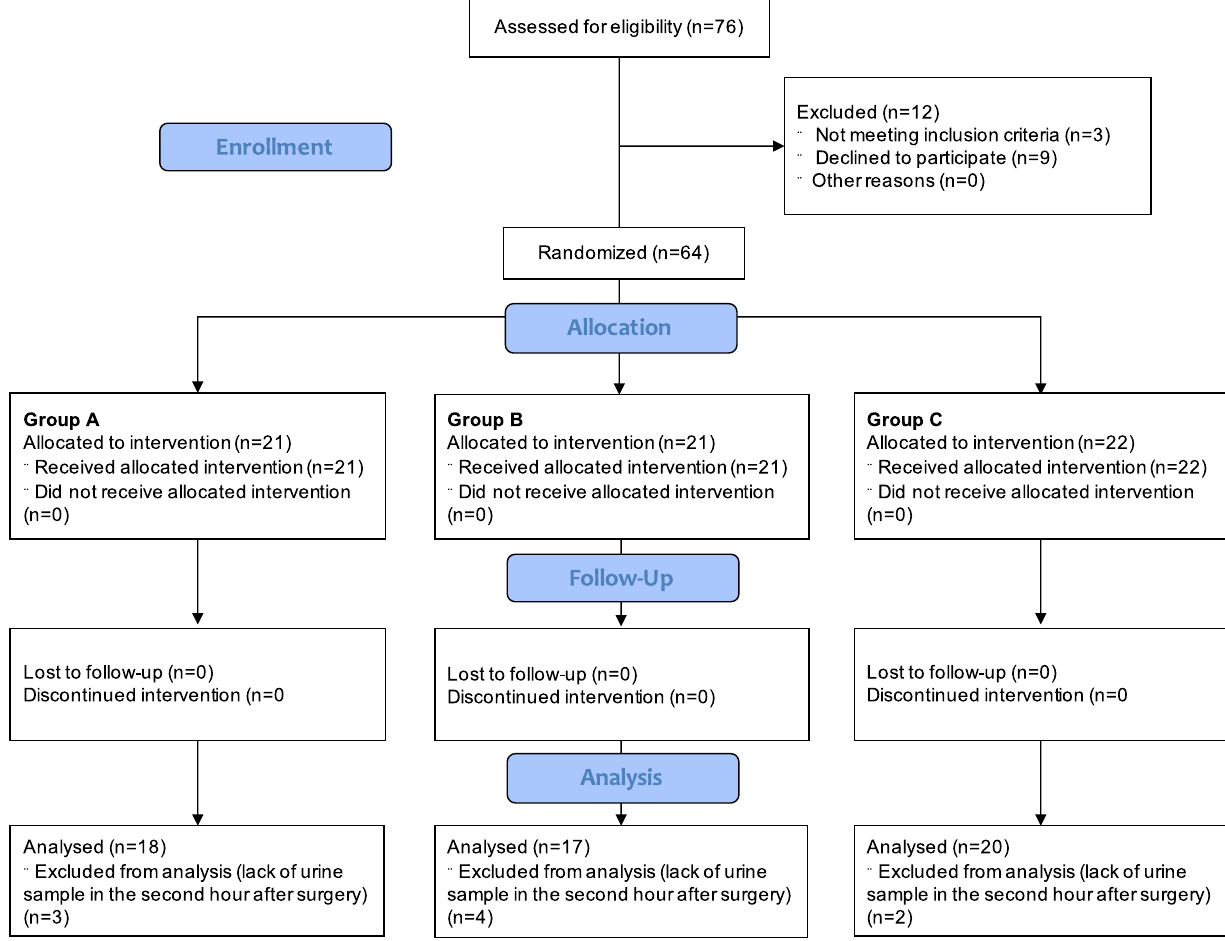
Figure 1. CONSORT flow chart of patients included in the study.